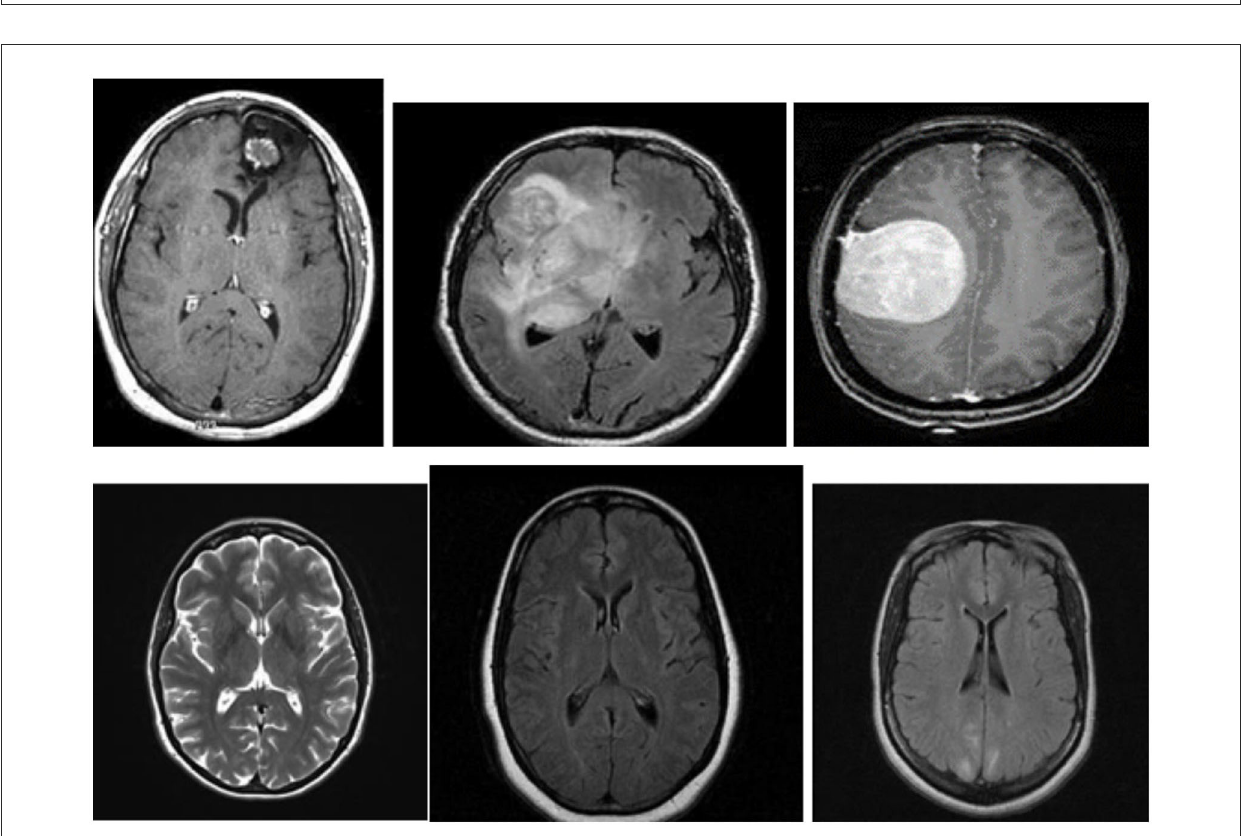
FIGURE3 MR images with and without tumor from the